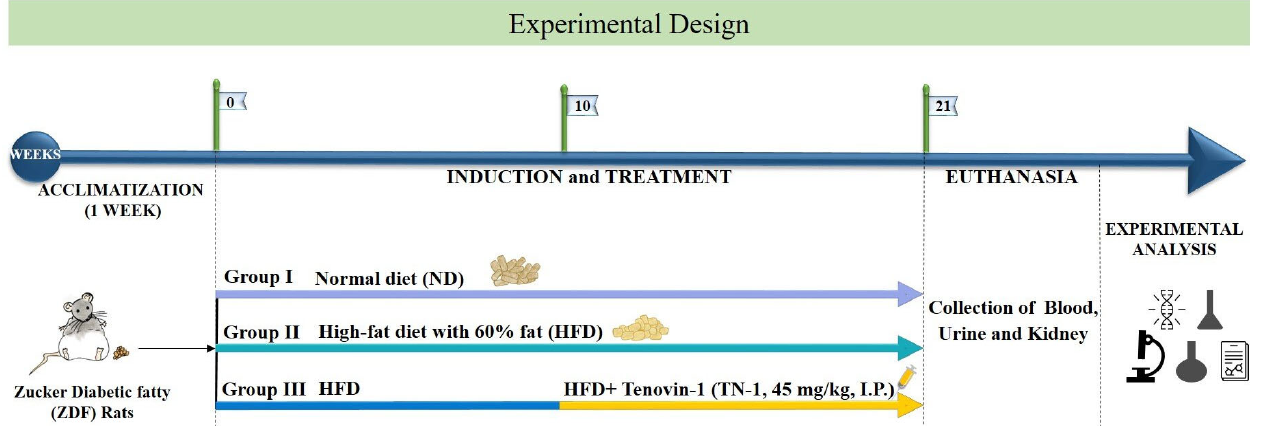
Figure 1. Experimental design. After one week of acclimatization, ZDF rats were randomly divided into 2 groups: the group that received a standard chow diet was the normal diet group (ND, n = 6), and the group that received a high ‐ fat diet was the experimental group (HFD, n = 12). The rats were split into two groups after 10 weeks of HFD feeding ( n = 6 in each group), with one group receiving only an HFD ( n = 6) and the other receiving an HFD plus Tenovin ‐ 1 treatment (HFD + Tenovin ‐ 1) for 10 weeks. ND, normal diet; HFD, high ‐ fat diet.